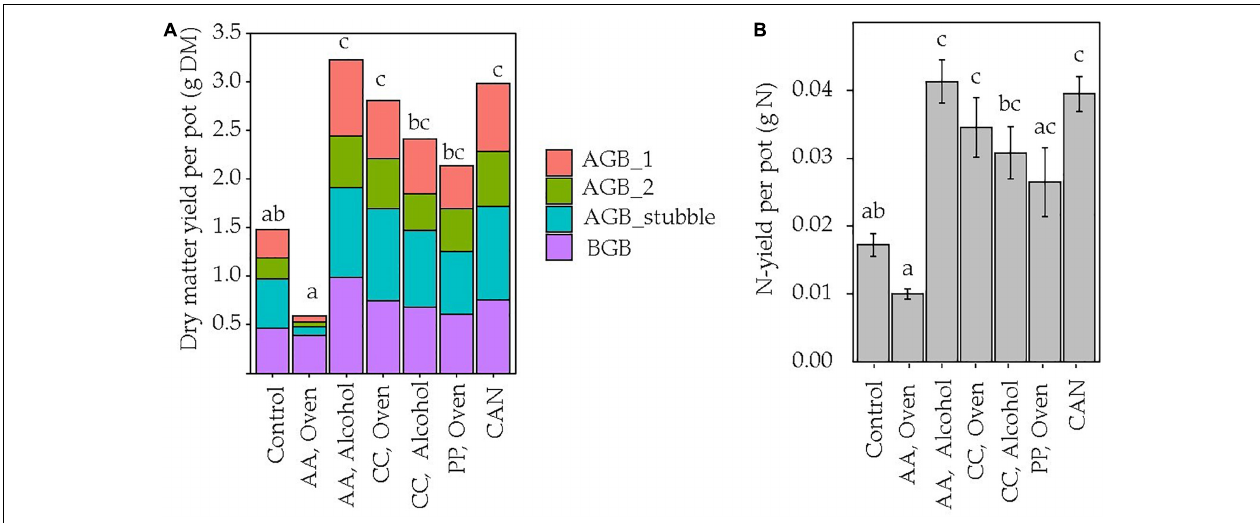
FIGURE 2 | (A) Sum of the above- (AGB) and belowground biomass (BGB) after the two grass cuts. Yield increments of the first [AGB_1 (red)] and second cut [AGB_2 (green)], stubble biomass [AGB_stubble (blue)] and roots [BGB (purple)] are presented. (B) Nitrogen yield per pot. Mean values (A) and means plus standard error (B) are shown ( n = 5). Jellyfish-derived fertilizers [ A. aurita (AA), C. capillata (CC), P. periphylla (PP)] were applied as dry matter in amounts equivalent to an N rate of 50 kg N ha − 1 to an established pot-grown grass sward. No common lower-case letters indicate significant ( p < 0.05) differences between treatments.